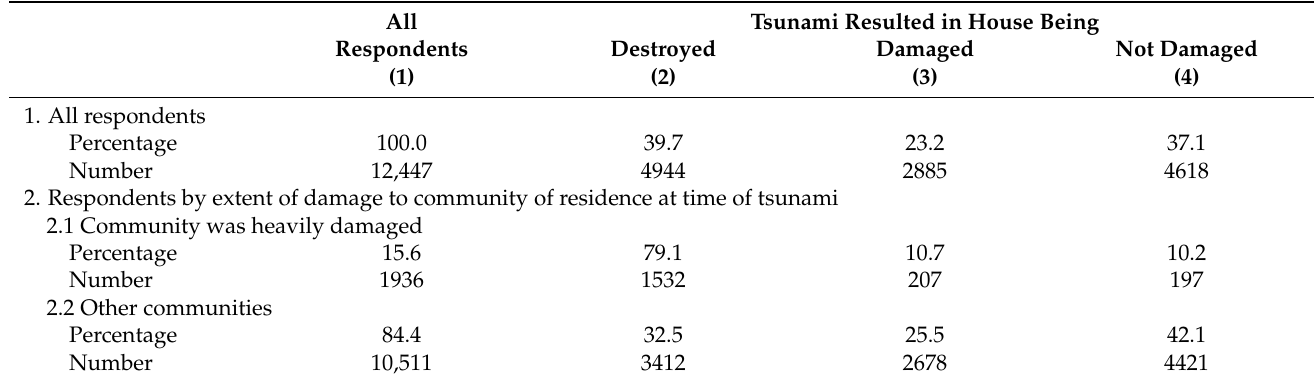
Table 1. Tsunami exposure and housing damage.